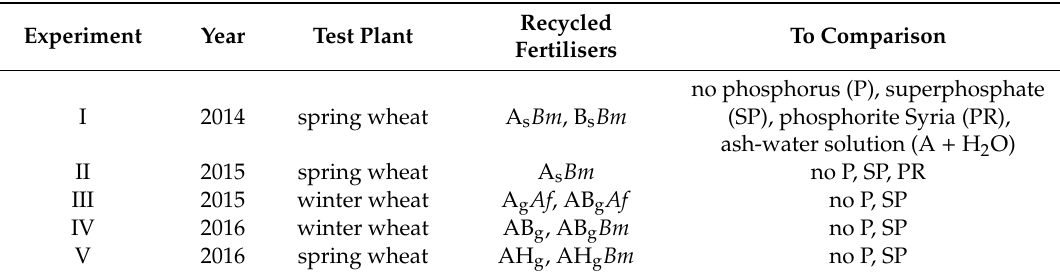
Table 2. Field experiments